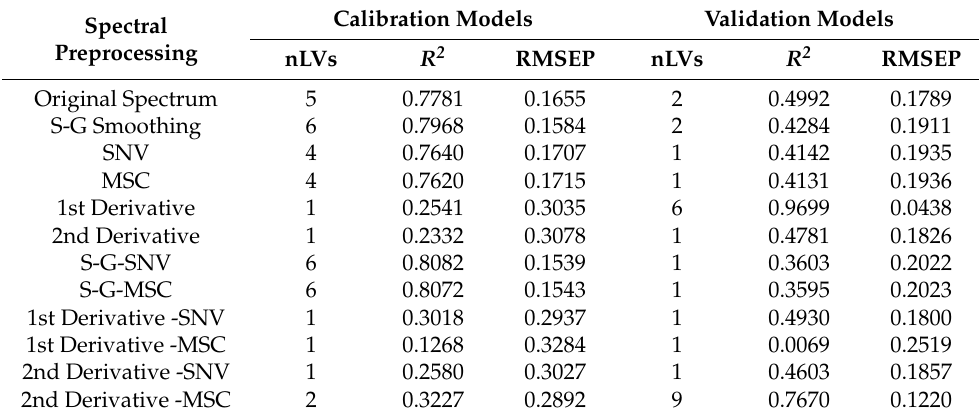
Table 4. PLS modeling of soil organic matter content with different pretreatment.